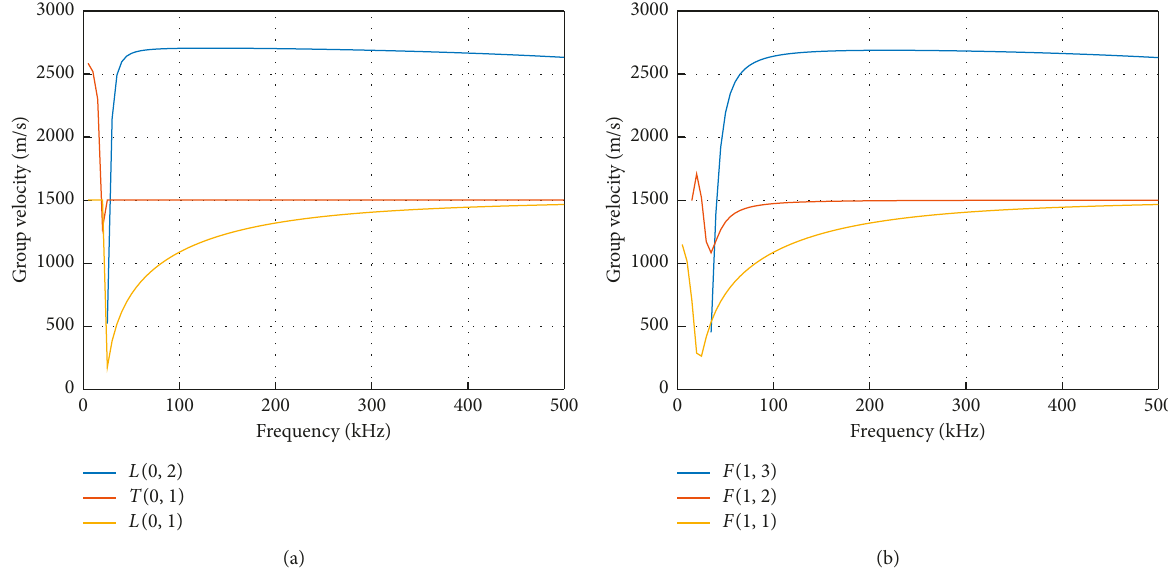
Figure 2: Group velocity dispersion curves in pipes with complete solidification, p � q � 0. (a) Group velocity curves of the axisymmetric guided wave. (b) Group velocity curves of the nonaxisymmetric guided wave.